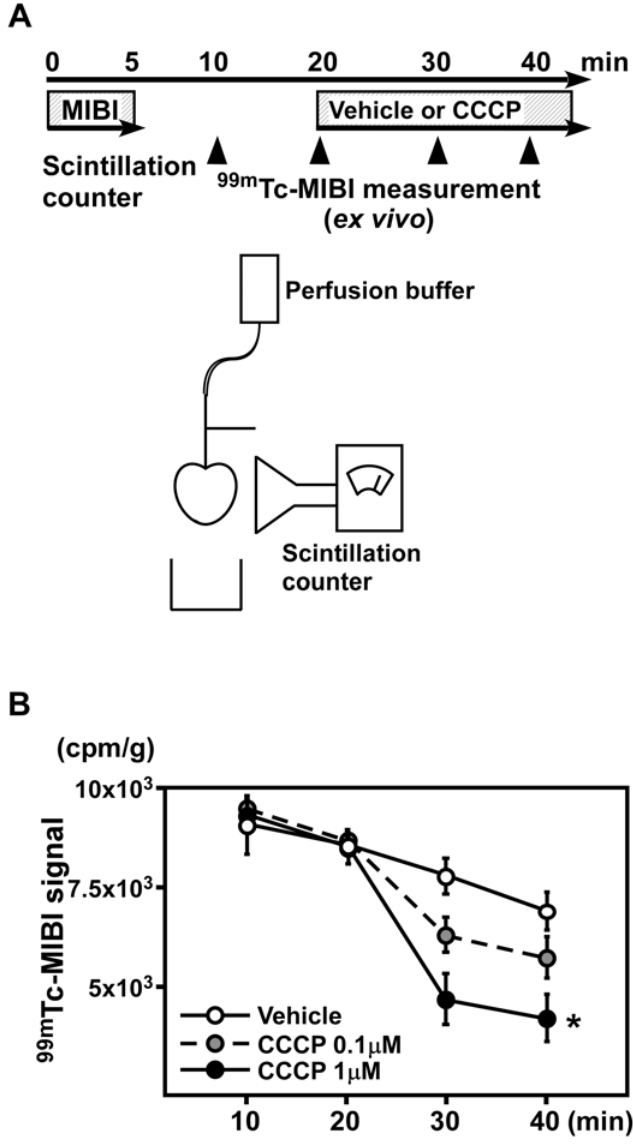
Figure 2. CCP decreased 99m Tc-MIBI signals in perfused hearts. (A) A schematic of the experiment. 99m Tc-MIBI signals were serially analyzed in perfused hearts. (B) The signals of 99m Tc-MIBI were decreased after perfusion of the same doses of CCCP used for the TMRE experiment. (n = 3 – 4 per group). * P < 0.05 versus